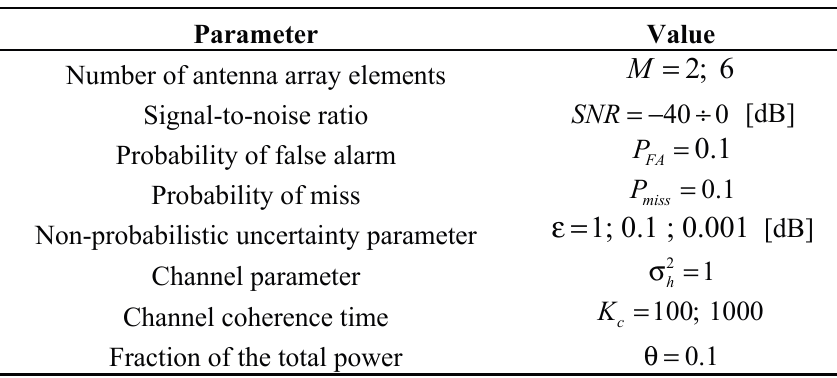
Table 1. Main simulation